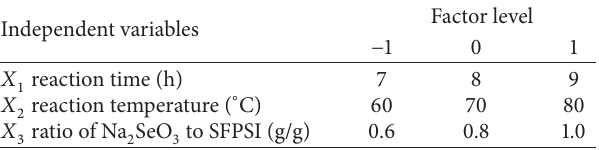
Table 1: Coding schedule of response surface